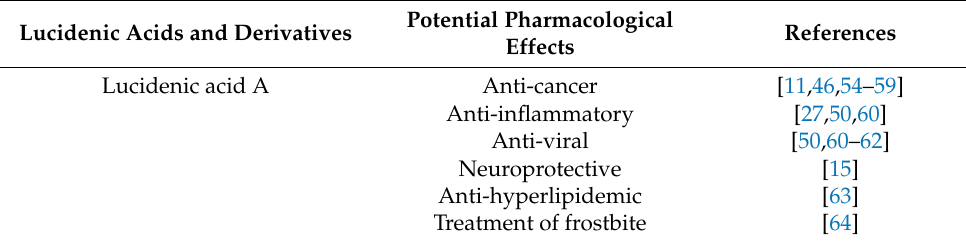
Table 4. Potential pharmacological effects of lucidenic acids and